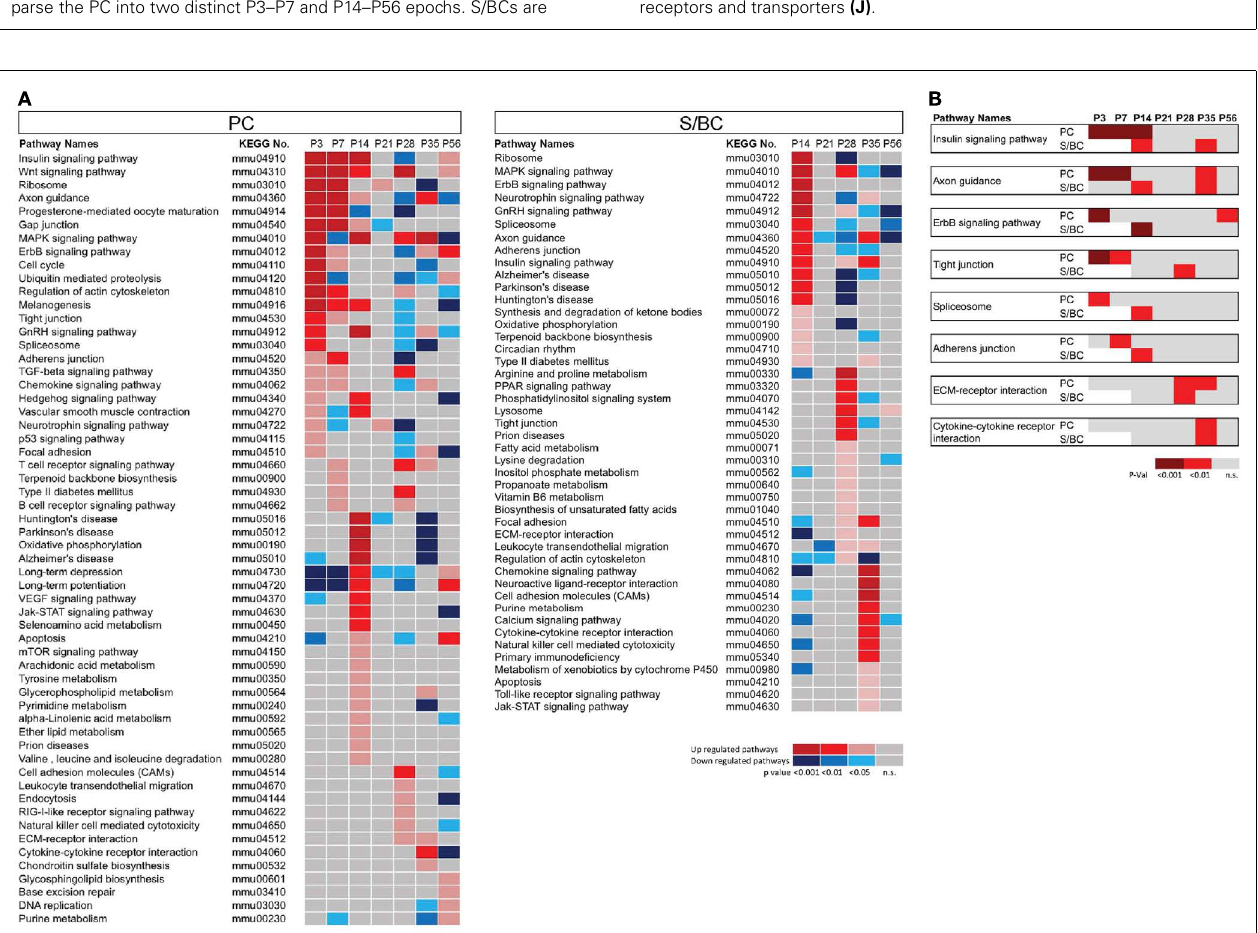
developmental stages that are either upregulated (red), down-regulated (blue), or non-significant enrichment (gray). (B) Comparison between PC and S/BCs shows delayed elevation of pathways involved in early postnatal development in